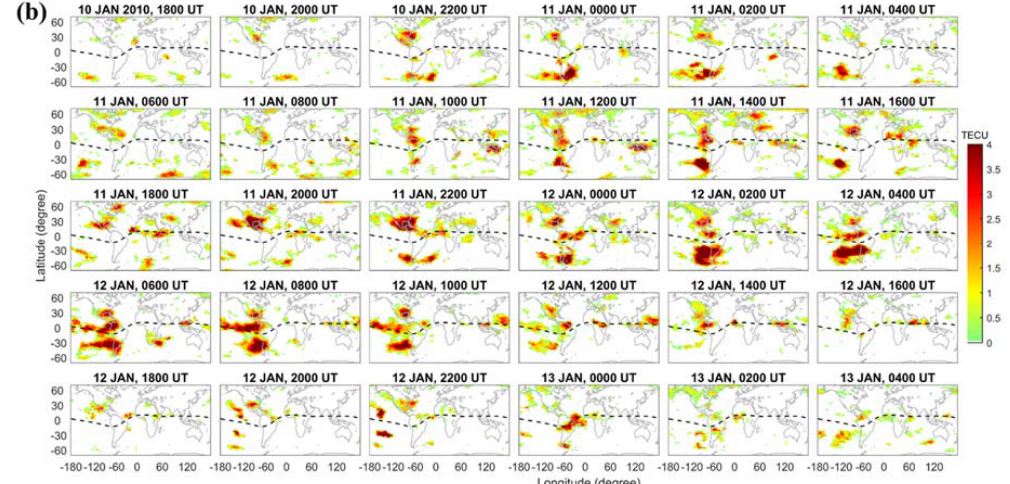
Figure 1. ( a ) Day ‐ to ‐ day variability in the total electron content (TEC) (red line) from Center for Orbit Determination in Europe (CODE) global ionospheric map (GIM) at 25° N, 90° W. The TEC continuously exceeds the upper bound (UB) from 2000UT on 10 January 2010 to 0400UT on 13 January 2010. The gray and two black curves are the associated medians and UB/lower bound (LB), respectively. The bounds at the current timestep are constructed by the 1 to 30 previous days’ median, lower quartile, and upper quartile at the same universal time and lattices. ( b ) Global distribution of positive TEC anomaly (TEC–UB) from 10 to 13 January 2010.